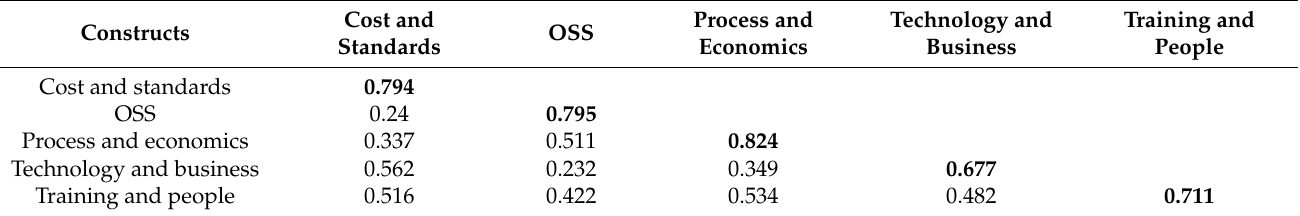
Table 3. Fornell–Larcker analysis .